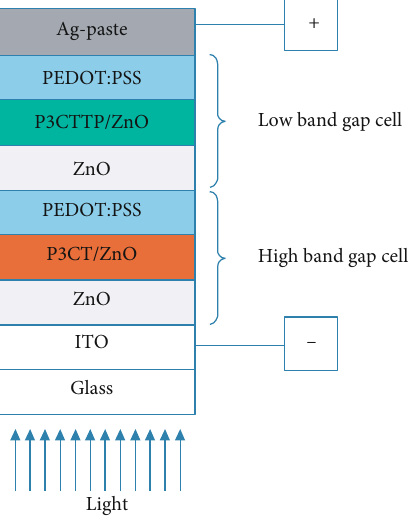
Figure 5: A schematic of an organic solar cell comprising eight layers with electrical connections [3].